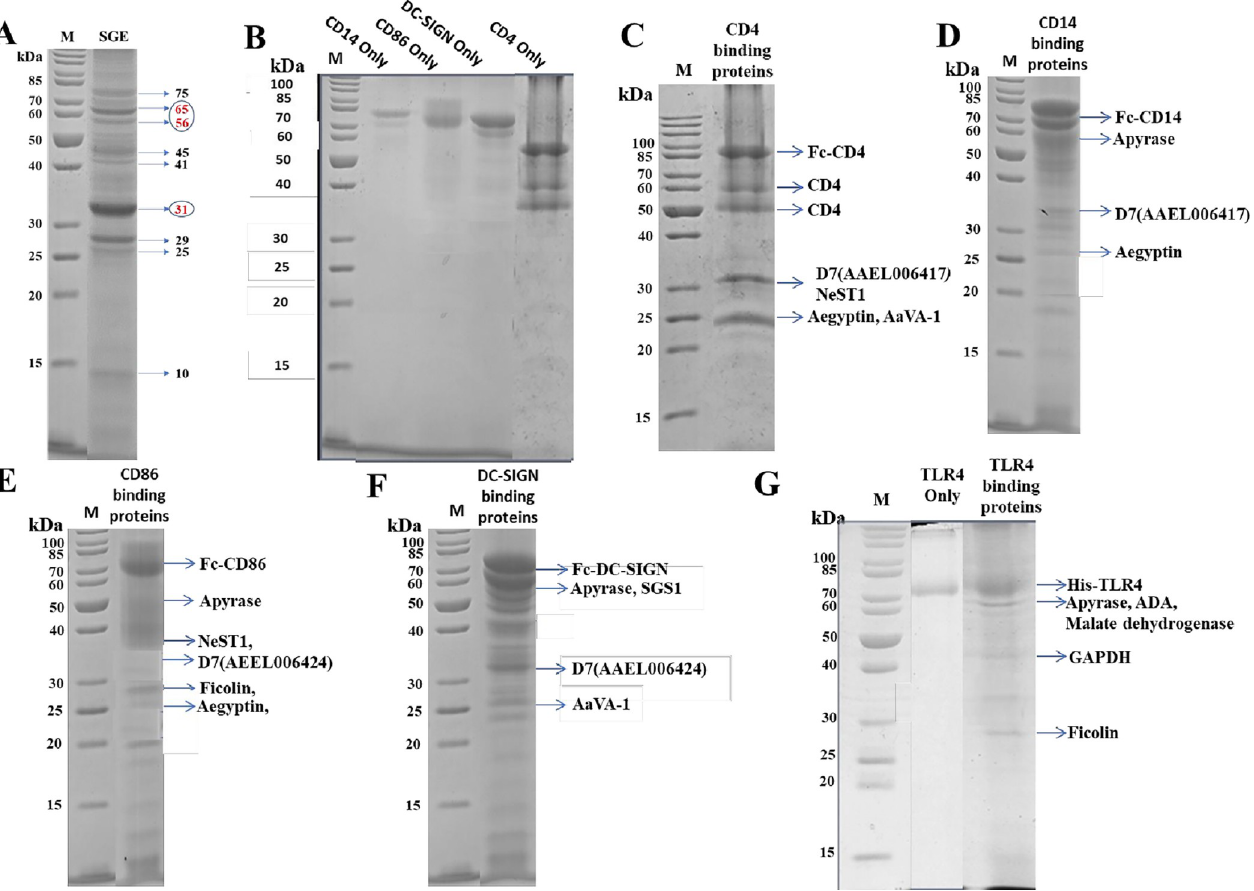
Fig 1. SDS-PAGE analysis of neat SGE, human receptor proteins and human receptor interacting SGPs. ( A ) A . aegypti SGE analysis showing 9 prominent bands and many smaller bands. The red font intense band labels with molecular weights of 56/65 kDa and 31 kDa, were previously analysed to contain seven and thirteen different proteins dominated by apyrase and D7(AEEL006424 and AEEL006417) proteins, respectively [42]. ( B ) CD14, CD86, DC-SIGN, and CD4 only control. ( C ) CD4-interacting SGPs. ( D ) CD14- interacting SGPs. ( E ) CD86-interacting SGPs. ( F ) DC-SIGN interacting SGPs. SGS1 is a 380 kDa protein. The identified lower molecular weight bands might be due to cleaved products as this protein is known to have three predicted cleavage sites [40]. ( G ) TLR4-interacting proteins. Due to post-translational modifications and similar molecular weight of SGPs, a single band could contain more than one protein merged into that